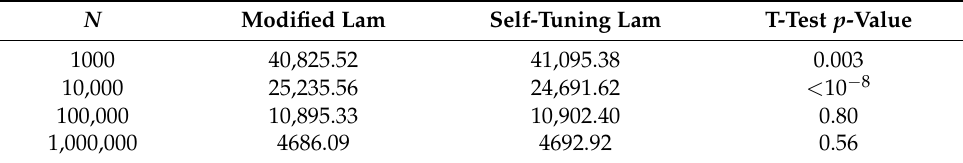
Table 20. Average cost of solution to TSP with 1000 cities distributed within a 100 by 100 square.